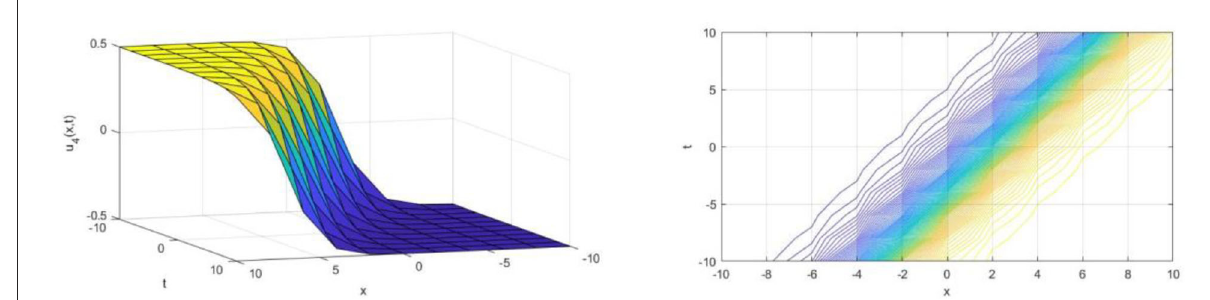
FIGURE4 The kink wave solution of u 4 ( x , t ) in 3D and contour.